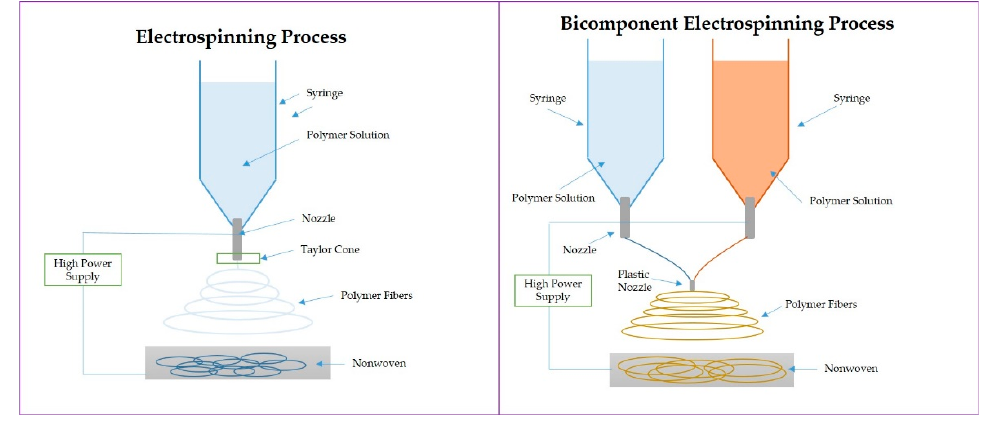
Figure 3. Scheme of the electrospinning process ( left ) and bicomponent electrospinning process ( right